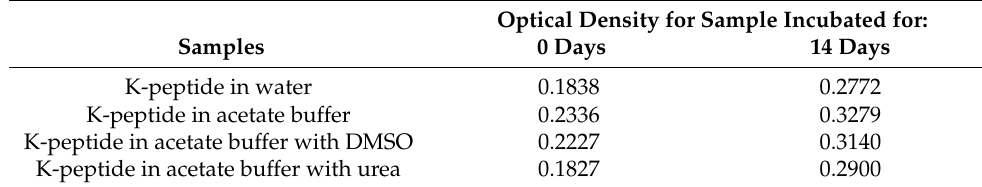
Table 1. The optical densities recorded at 350 nm for freshly prepared solutions of the K-peptide and for the samples incubated at 37 ◦ C for 14 days. Optical Density for Sample Incubated